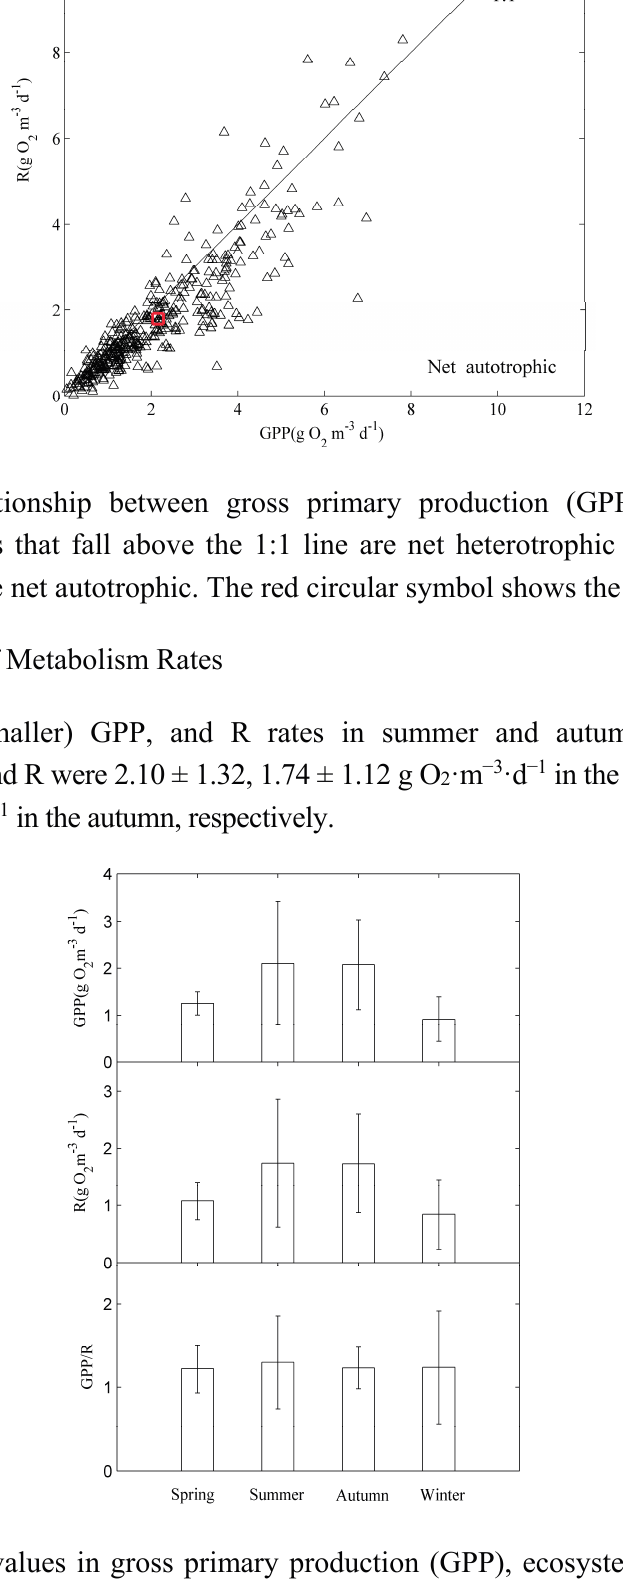
Figure 6. Seasonal values in gross primary production (GPP), ecosystem respiration (R), and GPP/R. Data are presented as the mean values and the error bars are